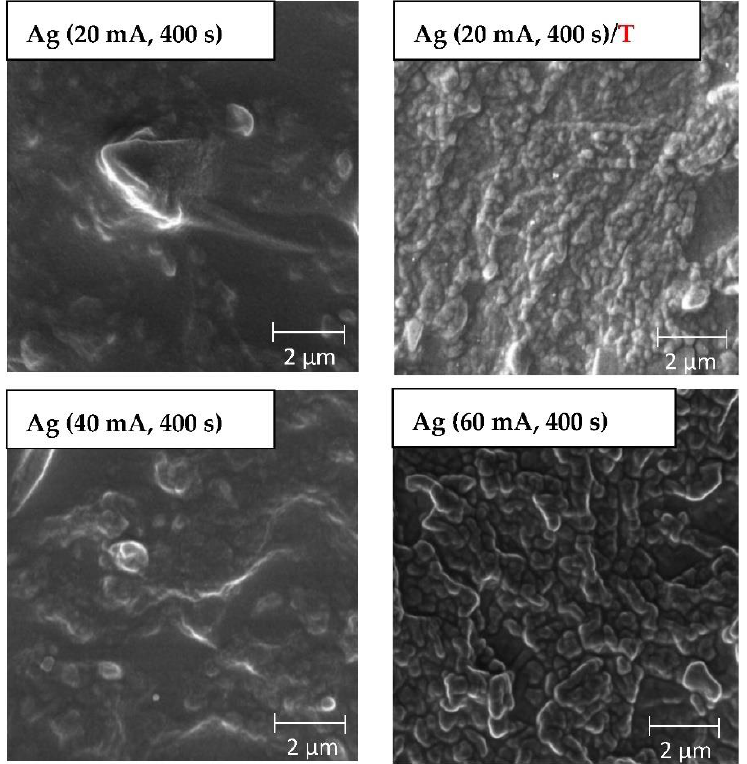
Figure 3. Scanning electron microscopy images of PDMS samples deposited with Ag for 400 s currents of 20 mA and subsequent heating at 285 °C, 40 mA, and 60 mA. The inspected area was 10 × 10 µm 2 .